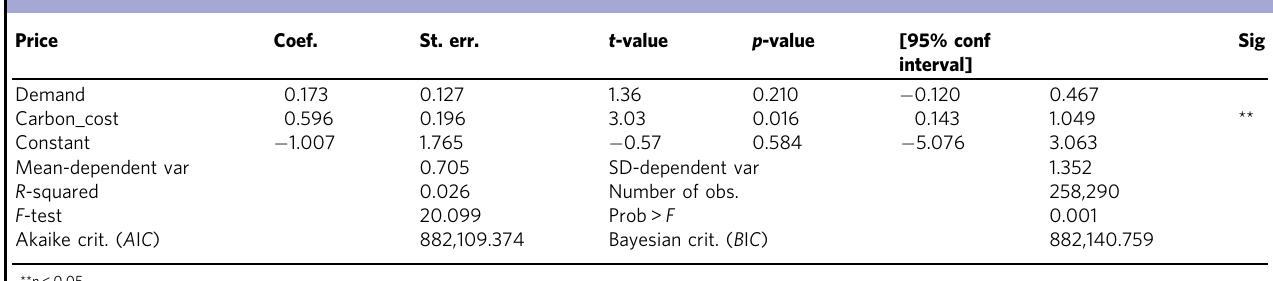
Table 5 Regression results from the generative additive model P e i (cid:2) P f i ¼ α Regions α 1 Kansai